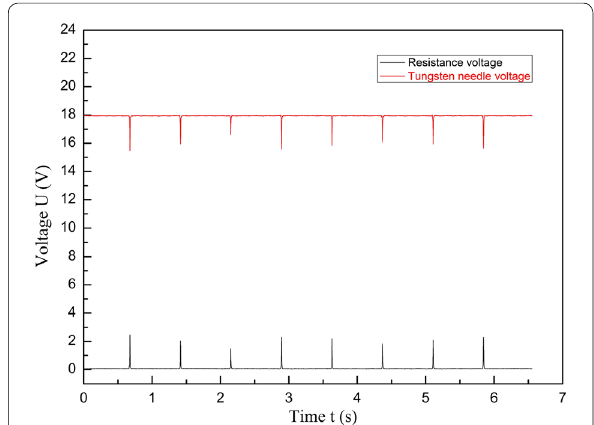
Figure 4 Waveform diagram of the probe voltage and the resistance voltage